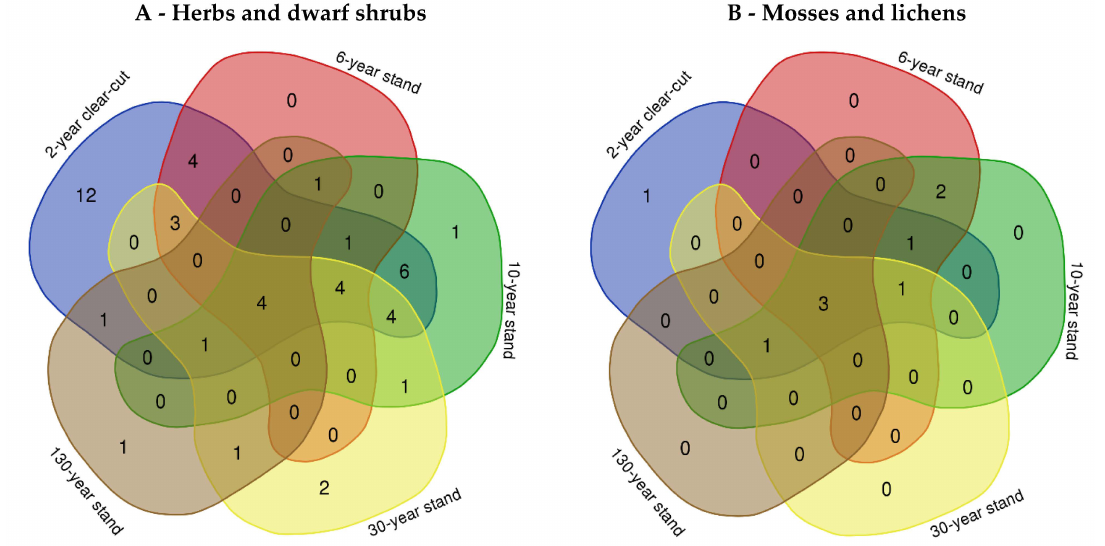
Figure 1. Venn diagram showing the diversity and overlap of the herbs and dwarf shrubs ( A ), mosses, and lichen ( B ) at the selected Pinus sylvestris sites, taken to represent clear-cuts (2-year-old clear-cut), young stands (6-year and 10-year stand), middle-aged stands (30-year stand) and mature stands (130-year